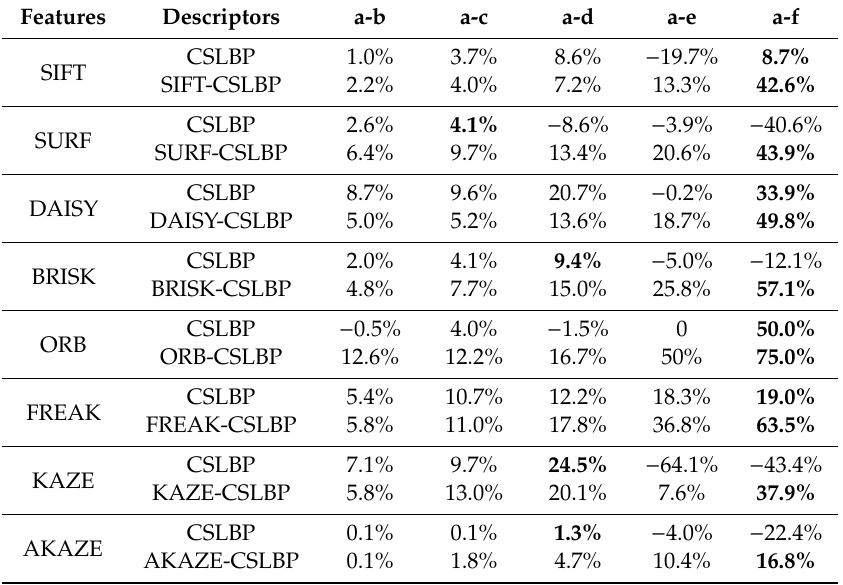
Table 2. The improved values of precision for the CSLBP and the combined descriptors compared to the original descriptors of Leuven sequence.